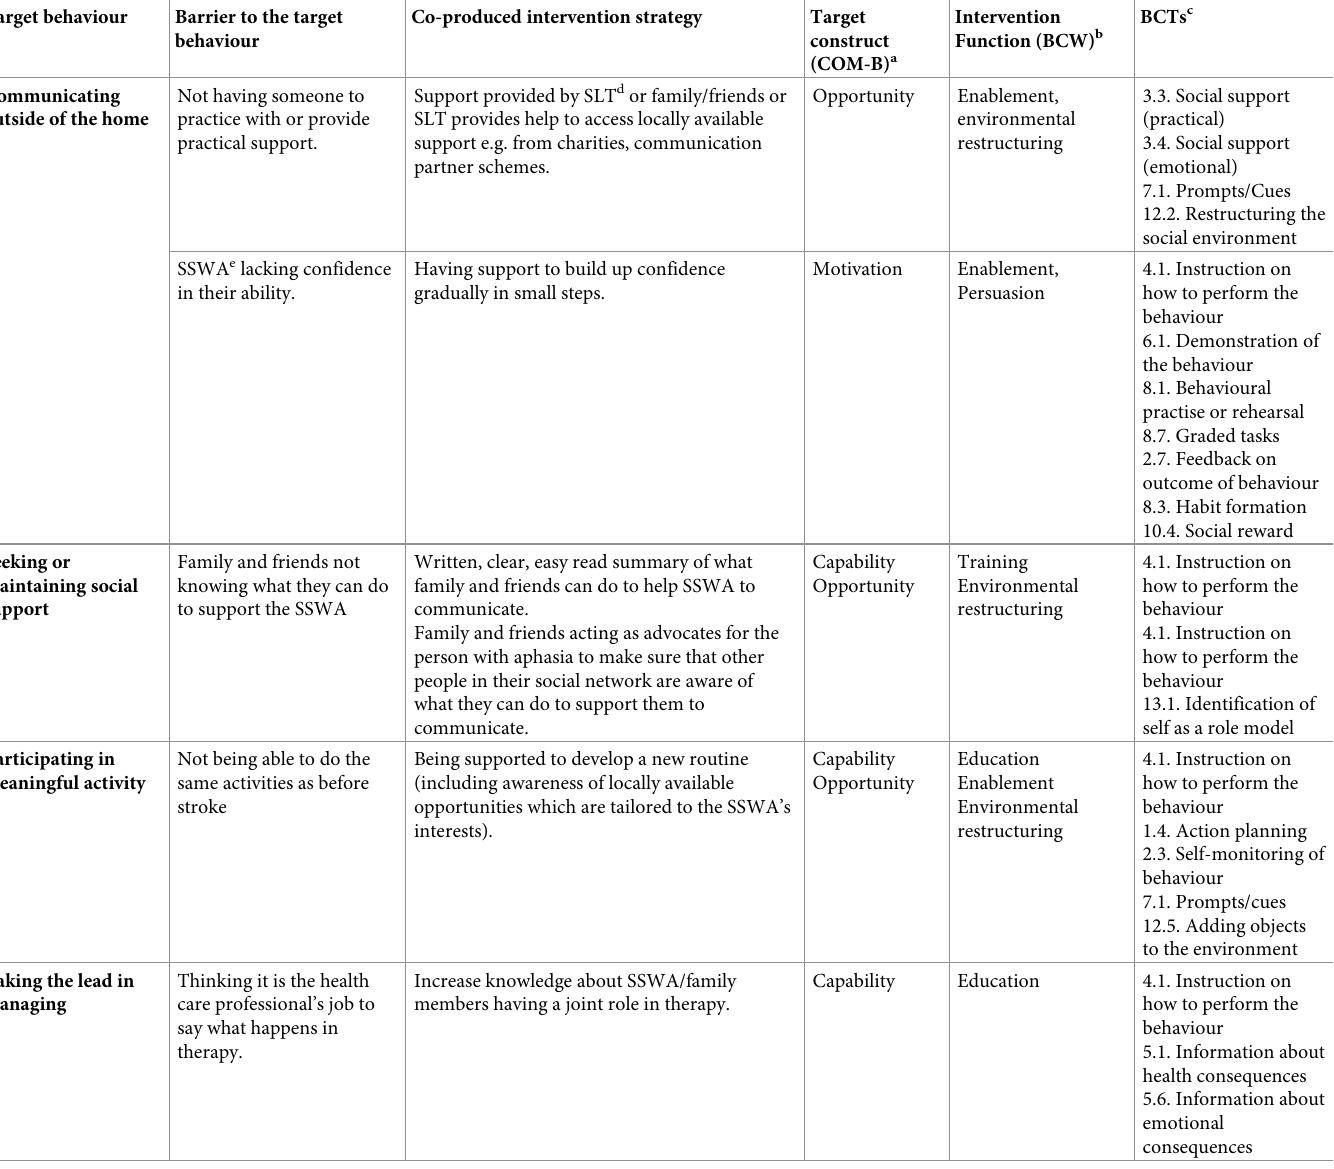
Table 4. Examples from the behavioural analysis to map co-produced intervention strategies to the BCW. Target